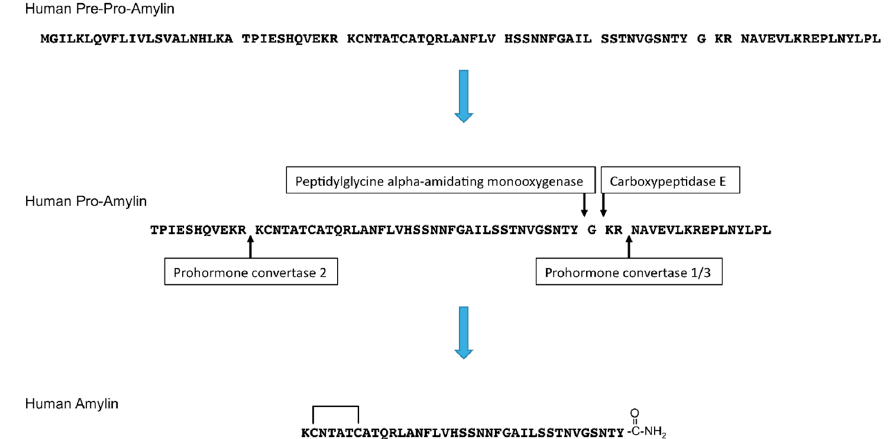
Figure 1. Amino acid sequences and processing of human pre-pro-amylin to generate mature human amylin. The N-terminal signal peptide is removed from the 89-amino acid pre-pro-amylin to produce the 67-amino acid pro-amylin. Pro-amylin is cleaved by prohormone convertase 1/3 and prohormone convertase 2, and the C-terminus of amylin is cleaved by carboxypeptidase E and amidated by peptidylglycine alpha-amidating monooxygenase. A disulfide bond at the N-terminus of amylin is subsequently formed.